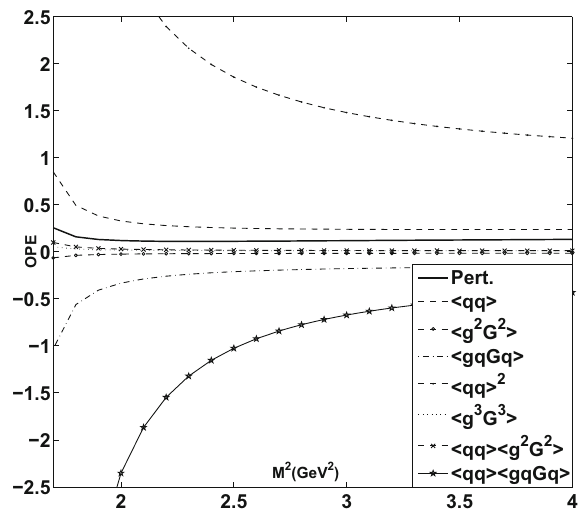
Fig. 4 The relative contributions of various OPE as a function of M 2 √ s 0 = 4 . 8 GeV for (cid:2) c ¯ D in sum rule (5) for